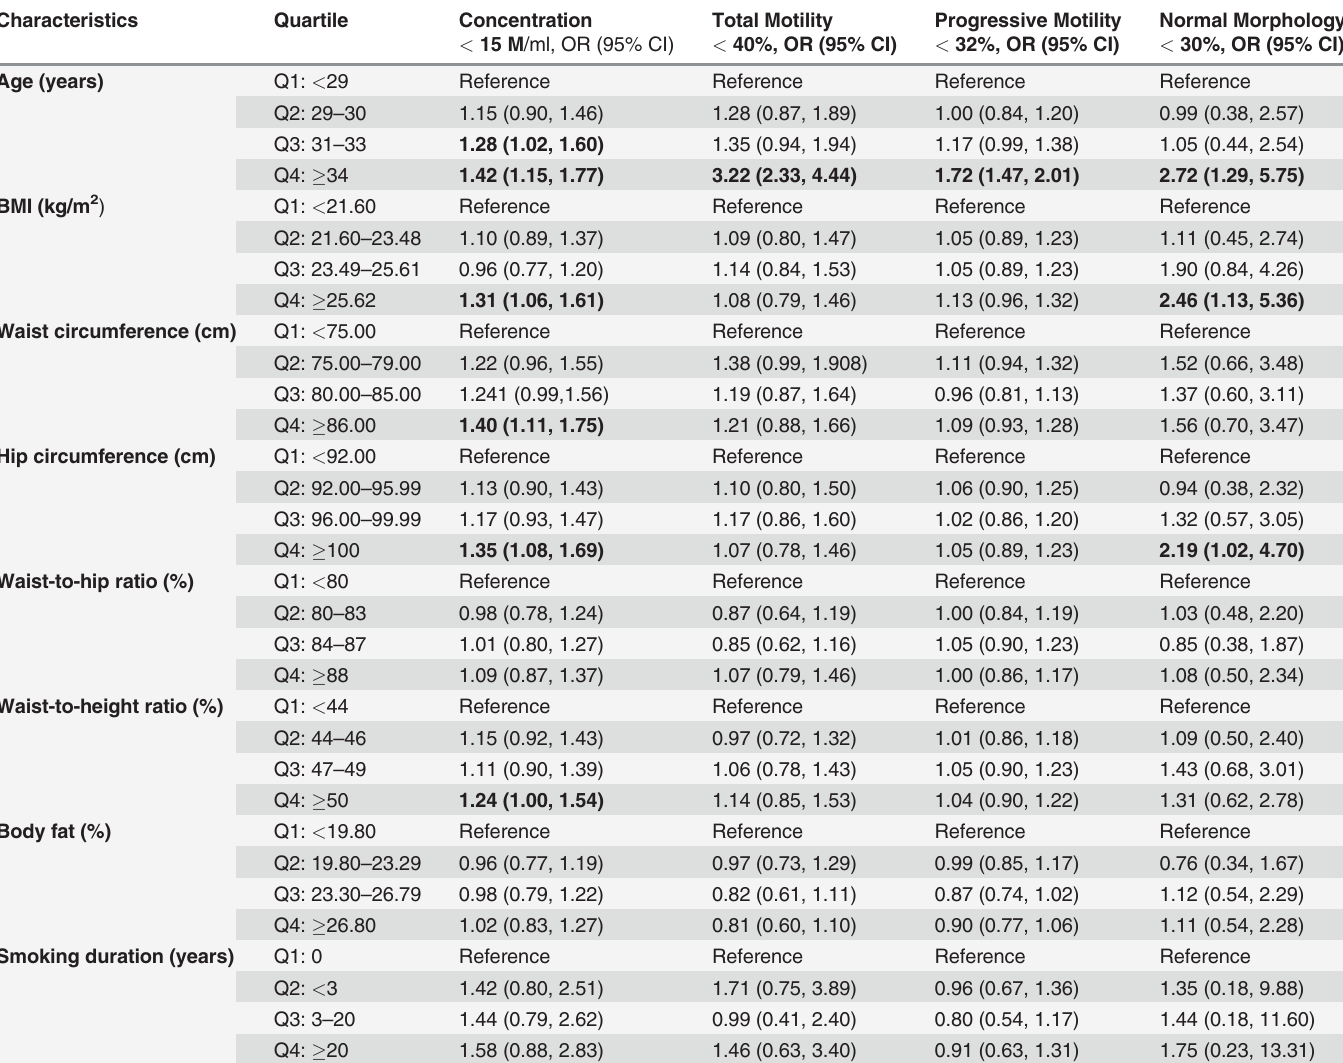
Table 4. The odds ratio (OR) and 95% con fi dence interval (CI) of abnormal semen quality with age and anthropometric indexes.